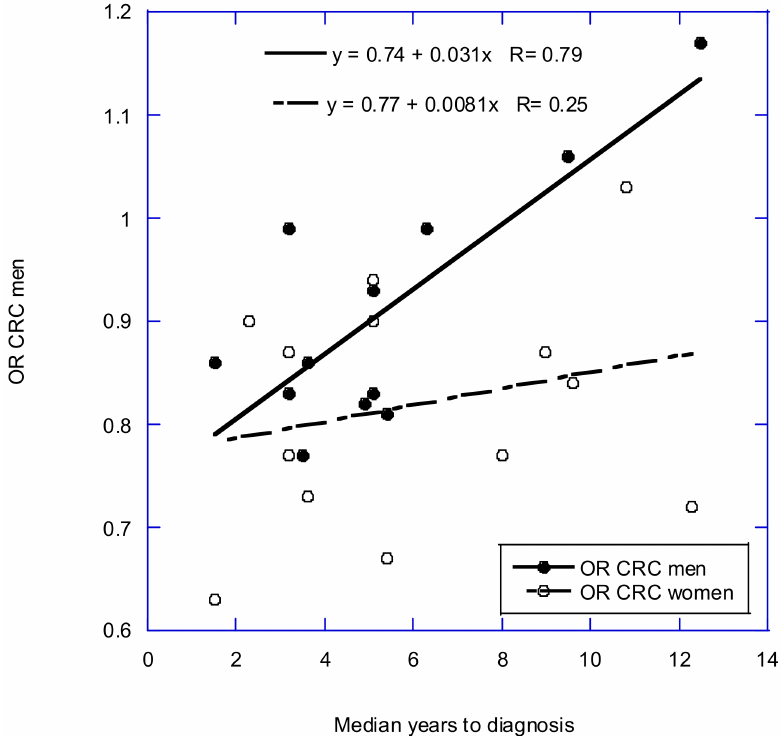
Figure 1. Plot of odds ratio (OR) for CRC against median years to diagnosis for data for men and women used in McCullough and colleagues